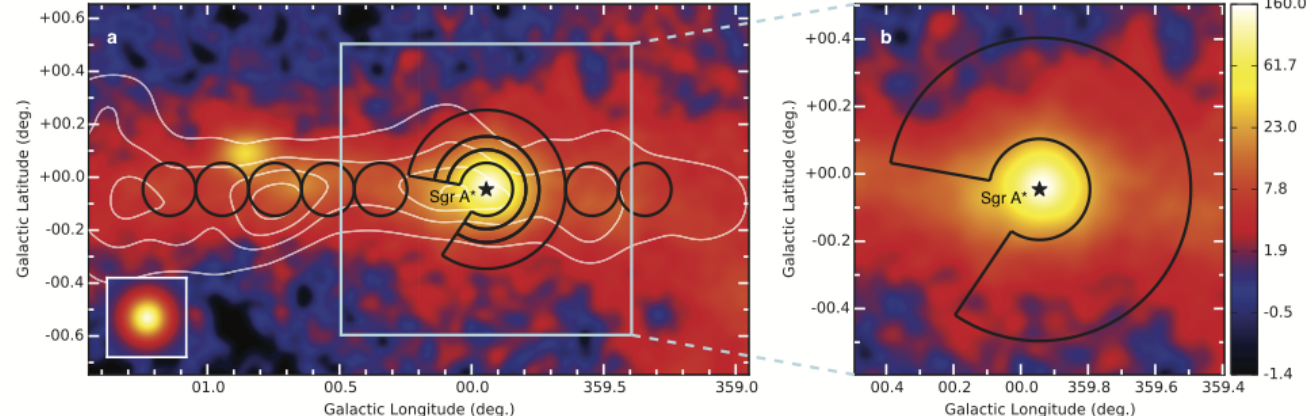
Figure 4. ( a ) H.E.S.S. gamma-ray excess map of the Galactic Center region. White contour lines indicate the density distribution of molecular gas traced by its CS line emission in the Central Molecular Zone. ( b ) Zoomed view of the inner 70 pc of the Galactic Centre region, and the contour of the region used to extract the spectrum of the diffuse emission. Figure from